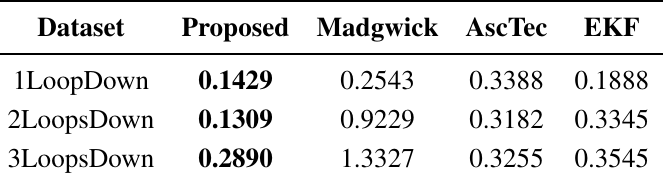
Table 3. RMS yaw angle error